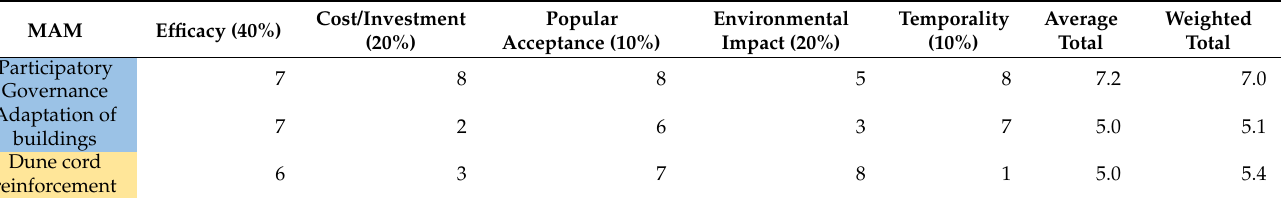
Table 4. Multi-criteria analysis performed by Group 2 for each MAM using their 5 elected criteria and respective importance for the weighted calculation. The colored cells represent adaptation (blue) and nourishment (yellow) measures respectively.